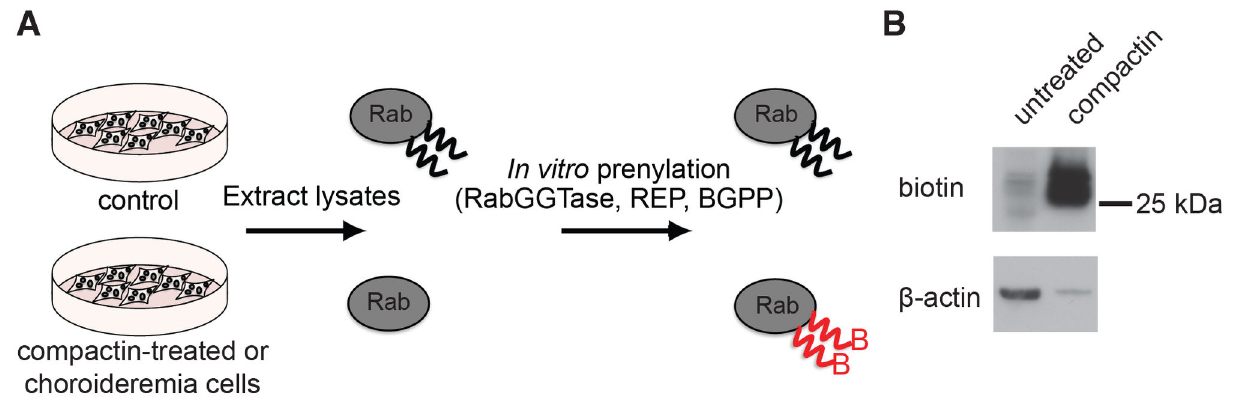
Figure 3. Schematic representation of in vitro prenylation assay. (A) Cell lysates are subjected to in vitro prenylation using a recombinant Rab prenylation machinery and the biotin-labeled analogue of GGPP, BGPP. Only those Rabs unprenylated in the cell will be labeled in the assay and can be visualized or purified through the biotin-tag. (B) Western blot analysis of cell lysate from untreated and compactin-treated BHK cells after in vitro prenylation with BGPP. Unprenylated Rabs are detected via the biotin-tag and actin serves as a loading control. BGPP: biotin-geranyl-pyrophosphate, GGPP: geranylgeranyl-pyrophosphate. Note that compactin treated sample is underloaded and the actual level of unprenylated RabGTPases are higher than they appear from comparison of the band’s intensities.